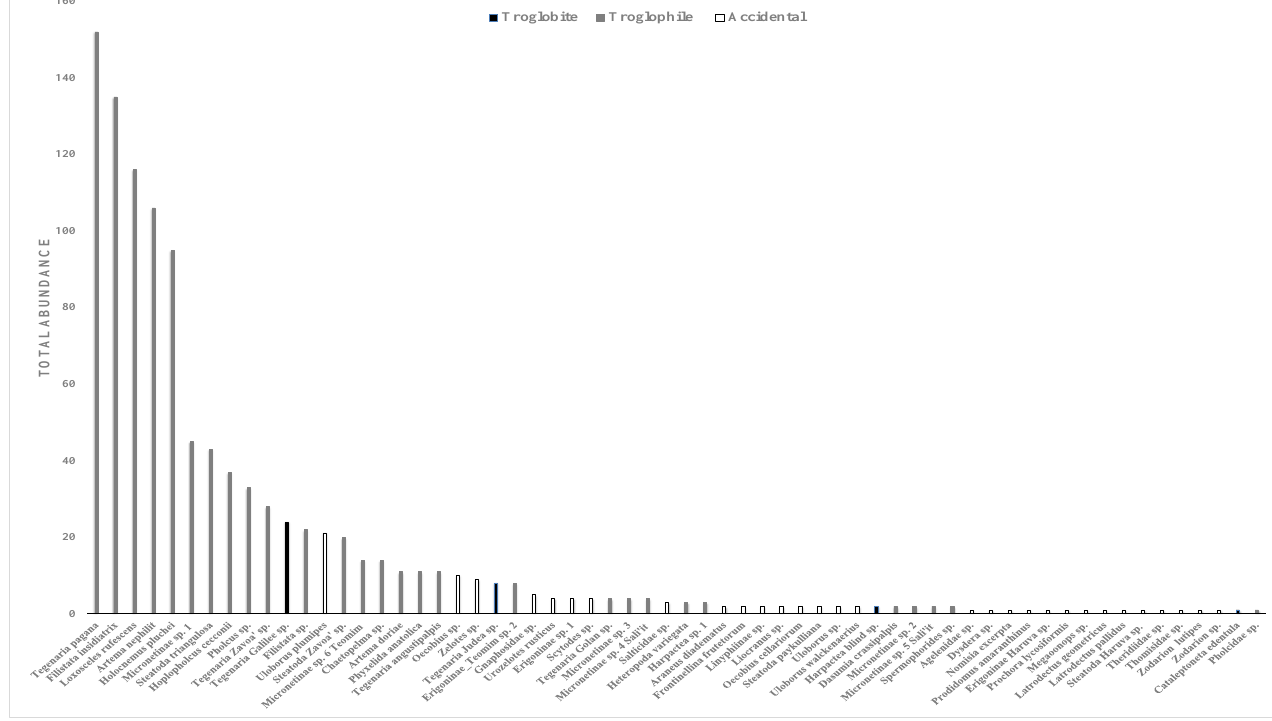
Table 1. Spider species richness and abundance (troglobite, troglophile, and accidentals) in caves by region (35 caves). Numbers denoted a specific cave (see Appendix A).